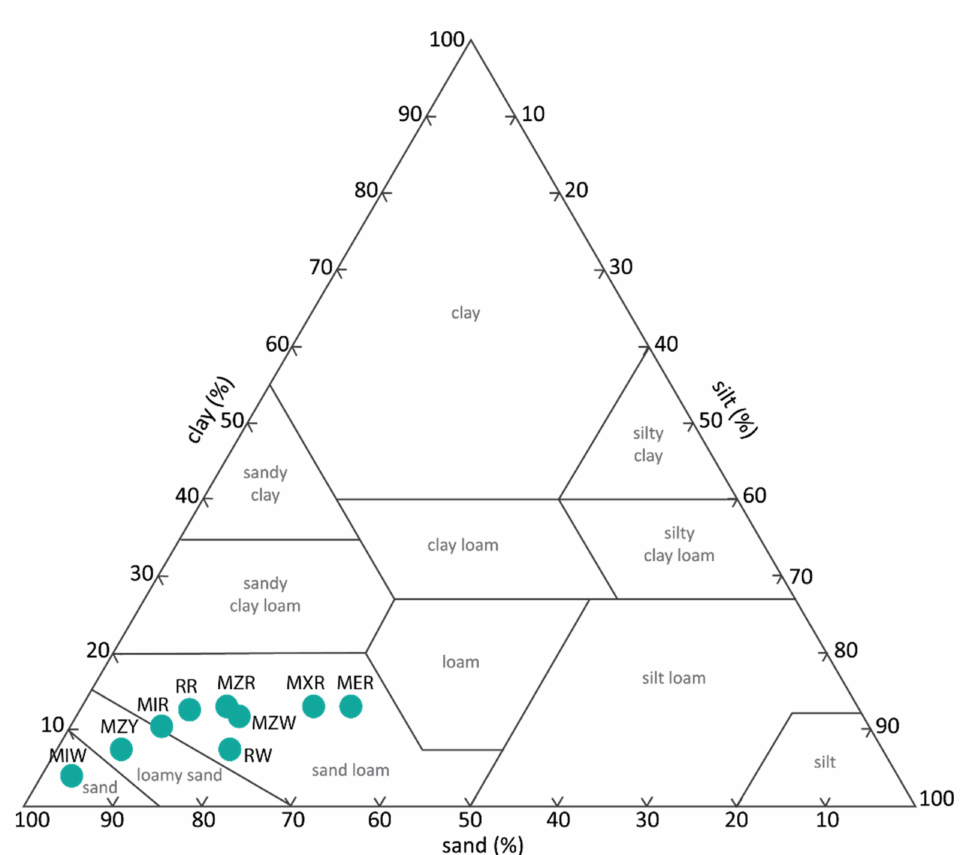
Figure 4. Granulometric classification of studied samples.